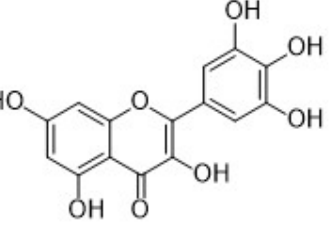
Figure 18. Chemical structure of myricetin (MYR).